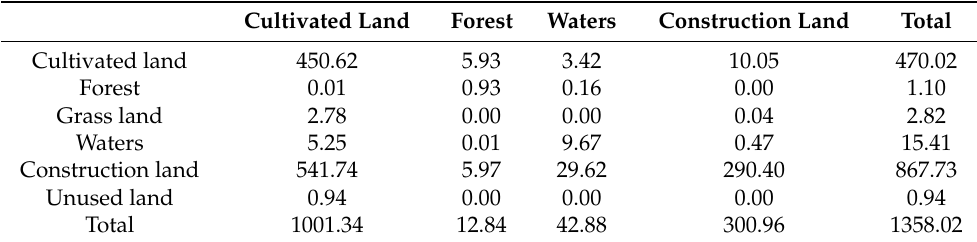
Table 2. BCT land-use type transfer matrix from 1990 to 2015.